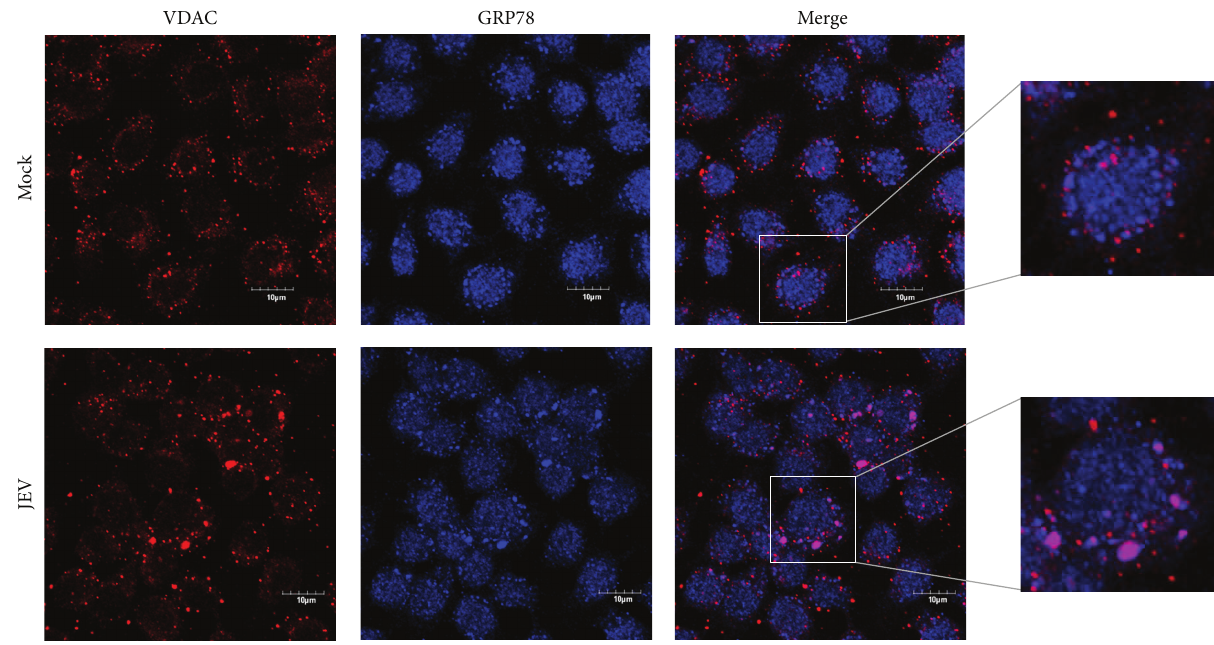
Figure 4: Location of VDAC and GRP78 in JEV infected C6/36 cells. Signal of VDAC and GRP78 extracted from Figure 3 for improved visualization purposes with